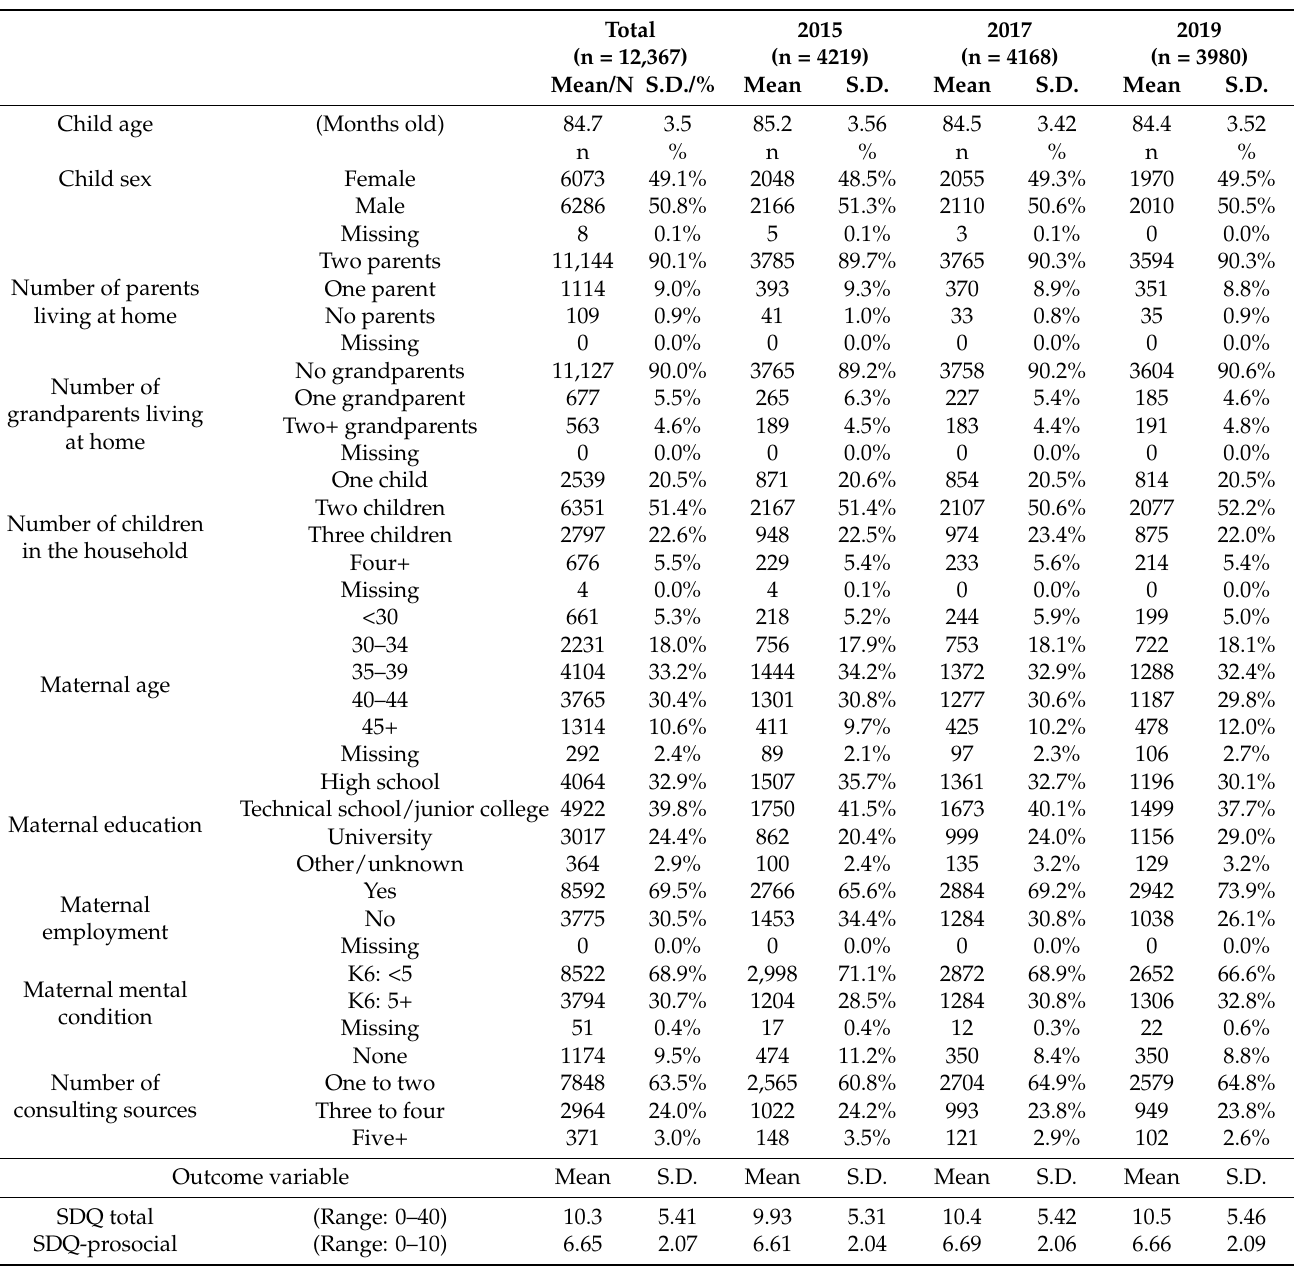
Table 1. Demographics of participants in 2015, 2017, and